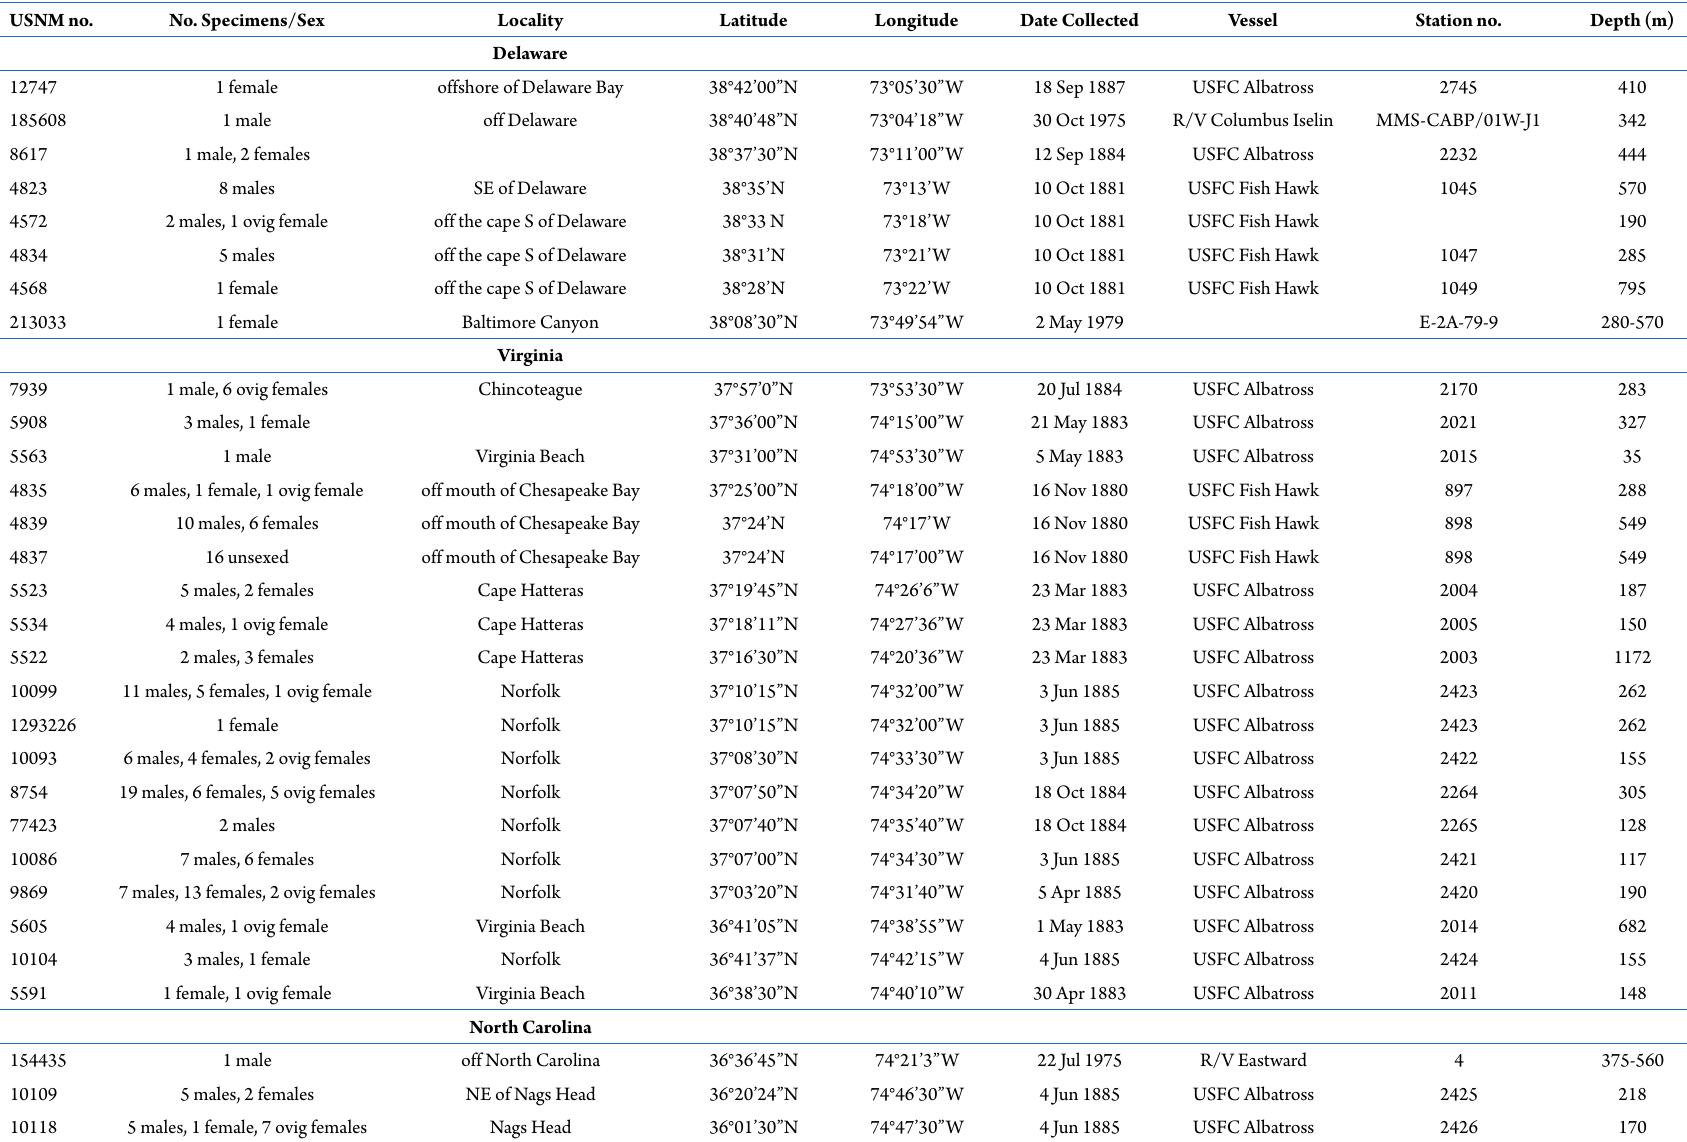
Table 1. Cont. USNM